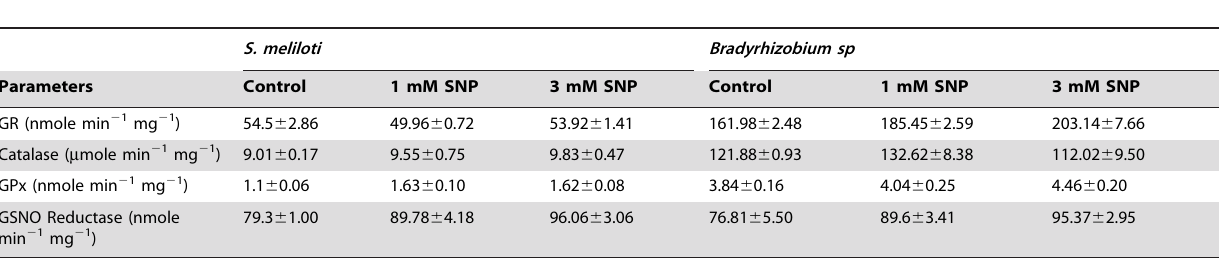
Table 3. Assessment of Glutathione reductase (GR), Catalase, Glutathione peroxidase (GPx) and GSNO reductase activity in S. meliloti 1021 and Bradyrhizobium sp after 30 minute stress with SNP in